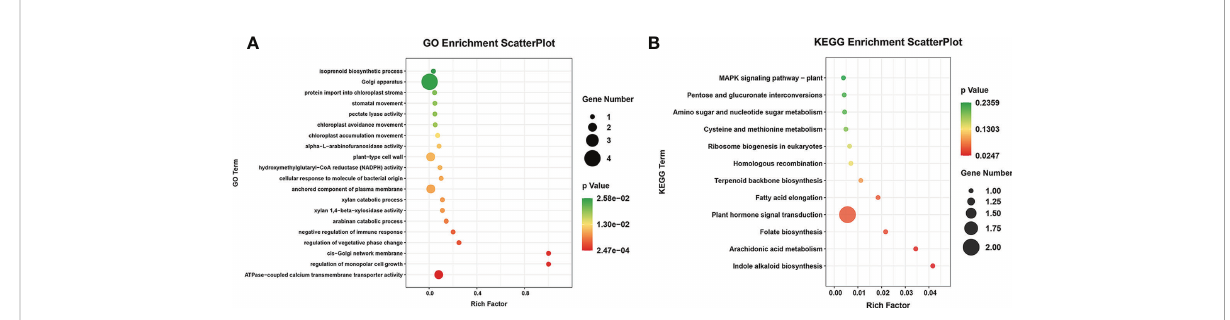
FIGURE 7 GO and KEGG analysis of miRNA targets speci fi c to fl ower developmental stages and varieties by miRNAome, transcriptome and degradome integrated analysis of tree peony. (A) GO analysis of target genes identi fi ed by integrated analysis of miRNAome, transcriptome and degradome. (B) KEGG pathway analysis of target genes identi fi ed by integrated analysis of miRNAome, transcriptome and degradome.